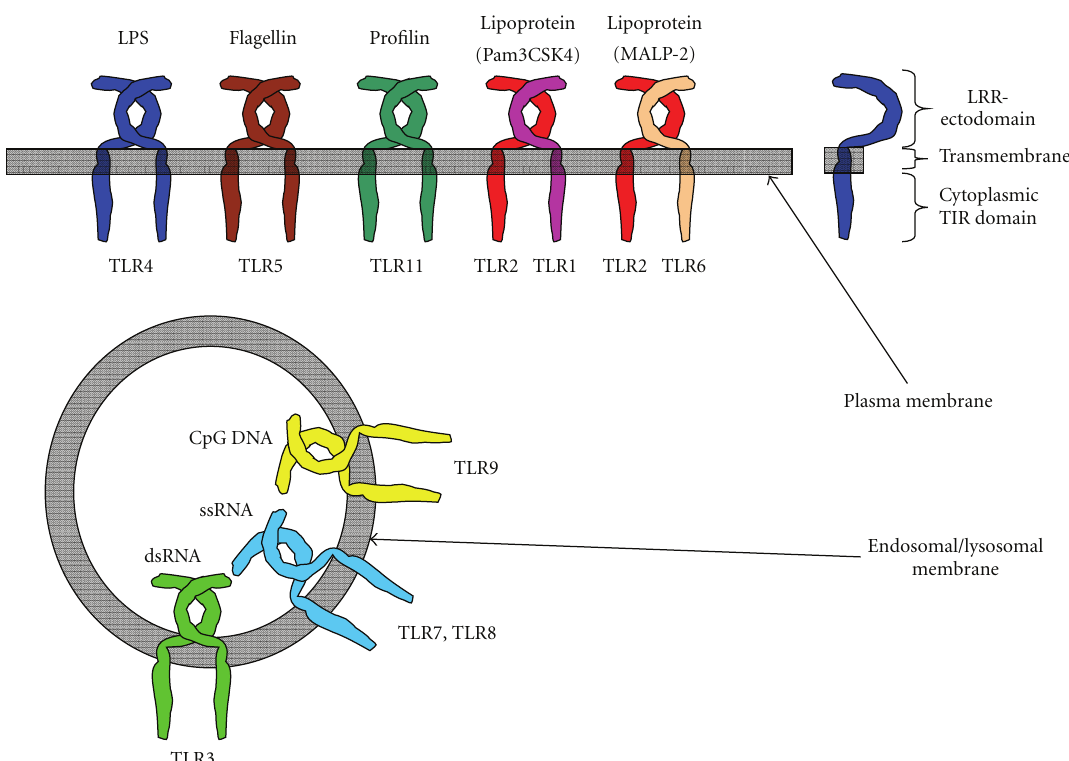
Figure 1: Extracellular and intracellular TLRs. TLRs can be divided into extracellular and intracellular TLRs. TLR1, TLR2, TLR4, TLR5, TLR6, and TLR11 recognize their ligands on the cell surface. On the other hand, TLR3, TLR7, TLR8, and TLR9 are intracellularly localized.